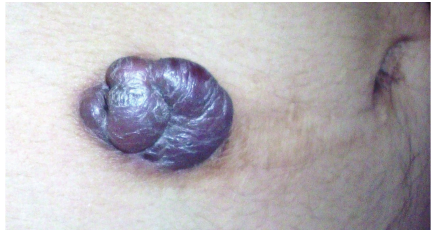
Figure 1: Clinical presentation.